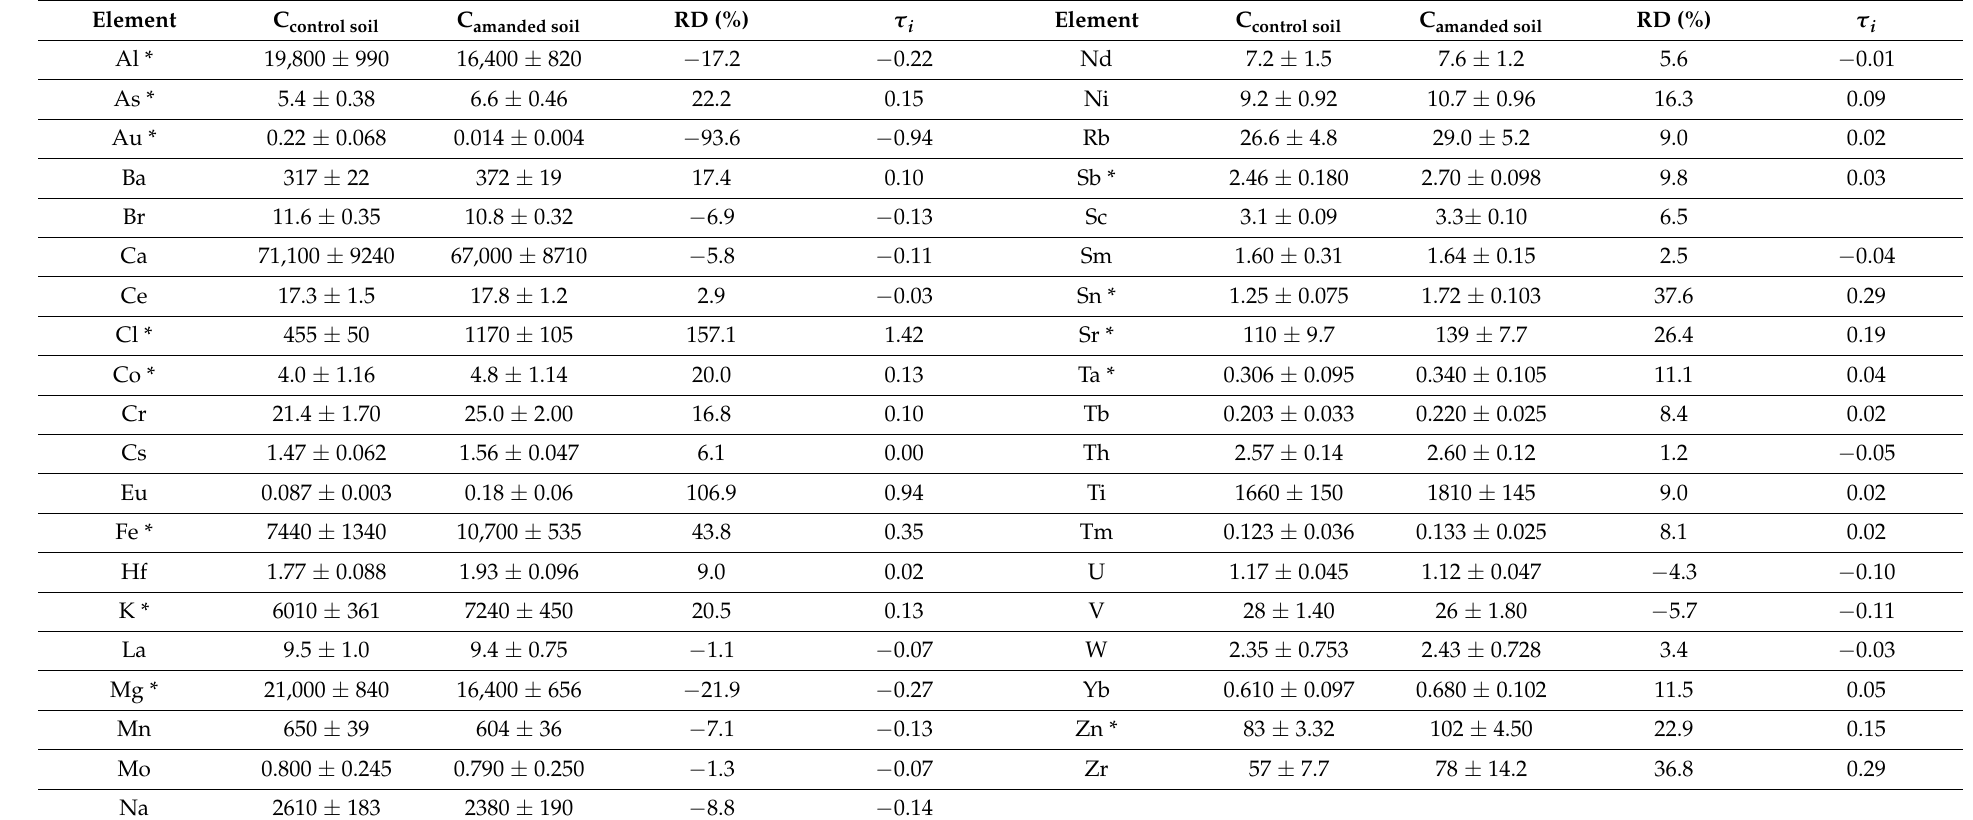
Table 1. Experimental and statistical results on soil (mg/kg ±